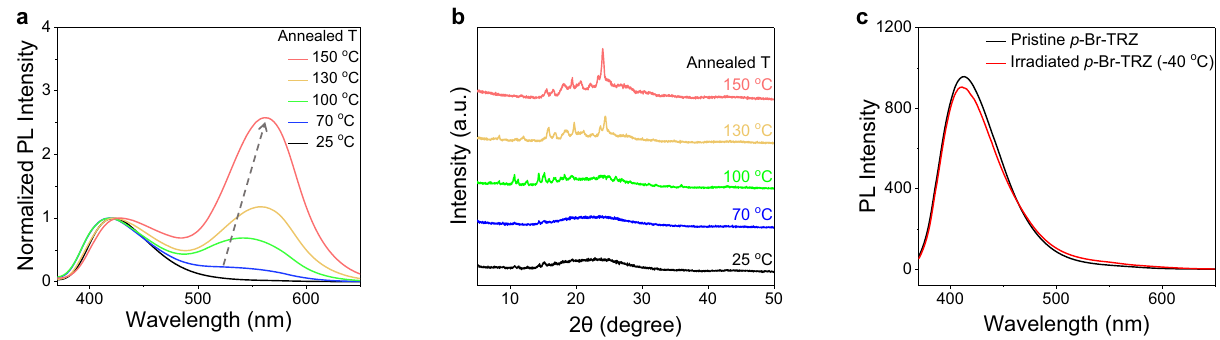
Fig. 4 RTP activated by thermal effect. a Emission and ( b ) XRD spectra of p -Br-TRZ (solid powder) recorded at 25 °C upon different heating treatments for 5 min at 25 (black line, no heating), 70 (blue line), 100 (green line), 130 (orange line), and 150 °C (red line), respectively. c Emission spectra obtained before and after UV irradiation (365 nm LED, 516 mW/cm 2 ) for 90 s at −